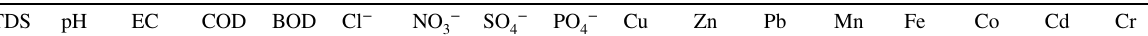
Table 2 Pearson’s correlation of physico-chemical parameters of water samples